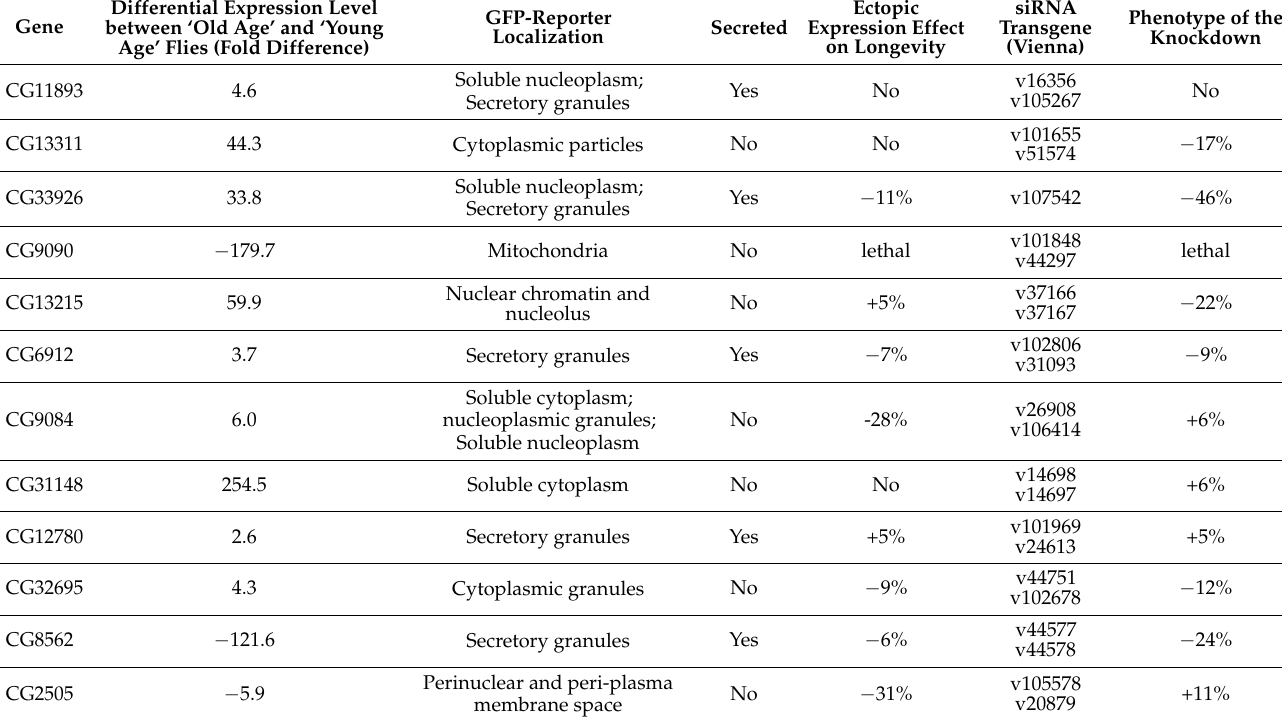
Table 5. Cellular localization and effects of ectopic expression and knockdowns on longevity. Twelve randomly selected genes from the list of 232 with unknown function. Column 2 shows the fold change of gene expression in aged flies; 3—cellular localization; 4—secretion; 5—effects of ectopic expression on longevity compared with Actin-GAL4 Drosophila; 6—names of siRNA knockdown transgenes; 7—effects of knockdowns on longevity compared with Actin-GAL4 Drosophila . All numbers included in columns 5 (Ectopic expression effect on longevity) and 7 (Phenotype of the knockdown) have p -value <